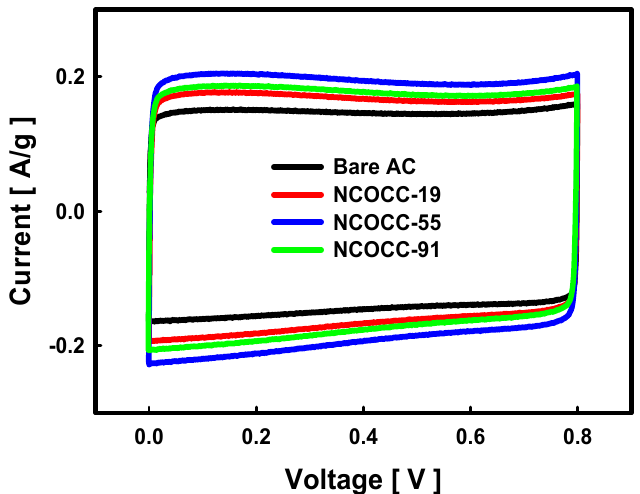
Figure 5. Cyclic voltammograms of NCOCCs electrode prepared by PiLP with different precursor